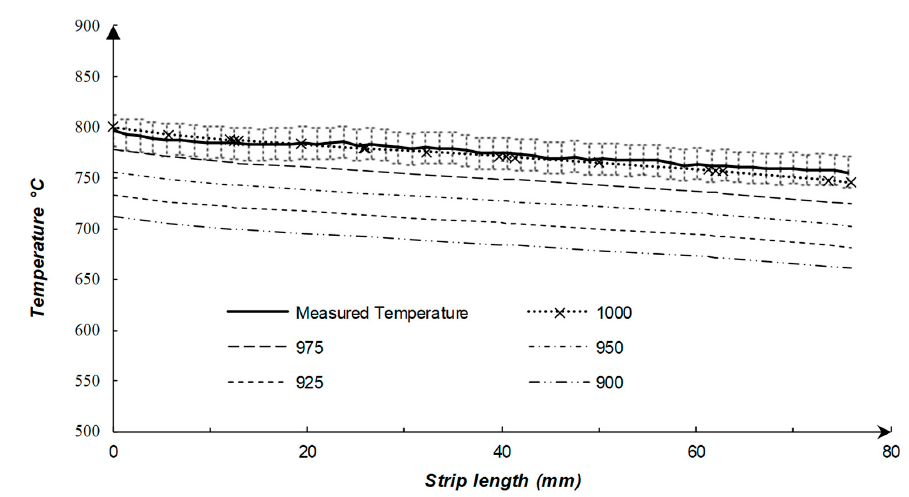
Figure 7. Validation of assumed boundary condition for the furnace temperature.